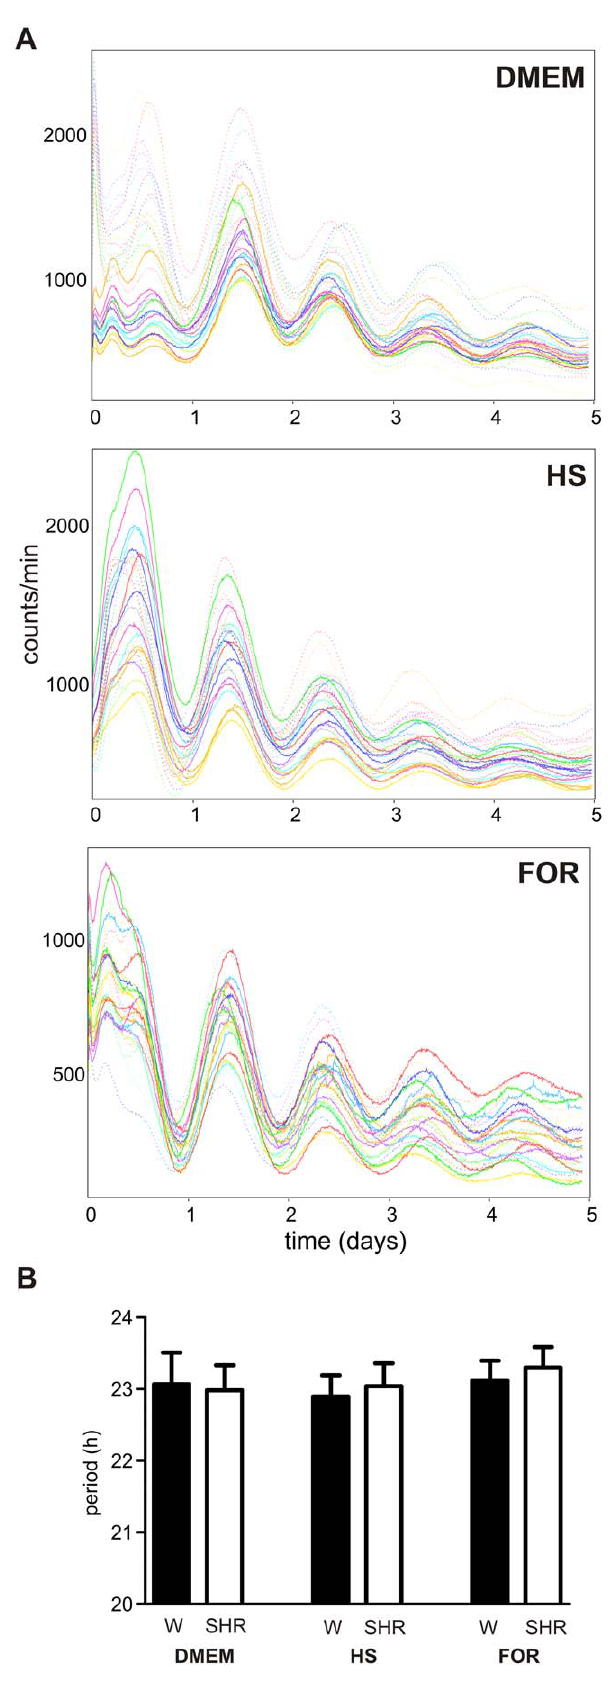
Figure 7. Circadian rhythms of fibroblasts from Wistar rats and SHR. A) Recordings of bioluminescence of spontaneously immortalized fibroblasts from Wistar rats (dotted lines) and SHR (full lines) transfected with Bmal1-dLuc circadian reporter. The fibroblasts were synchronized with simple medium exchange (DMEM), 10 m M Forskolin (FOR) or 50% horse serum (HS). B) Average periods ( 6 S.D.) of the circadian rhythm of spontaneously immortalized fibroblasts from Wistar rats (full column) and SHR (open column) synchronized as described in A. No significant differences between the periods of circadian rhythms in both rat strains were